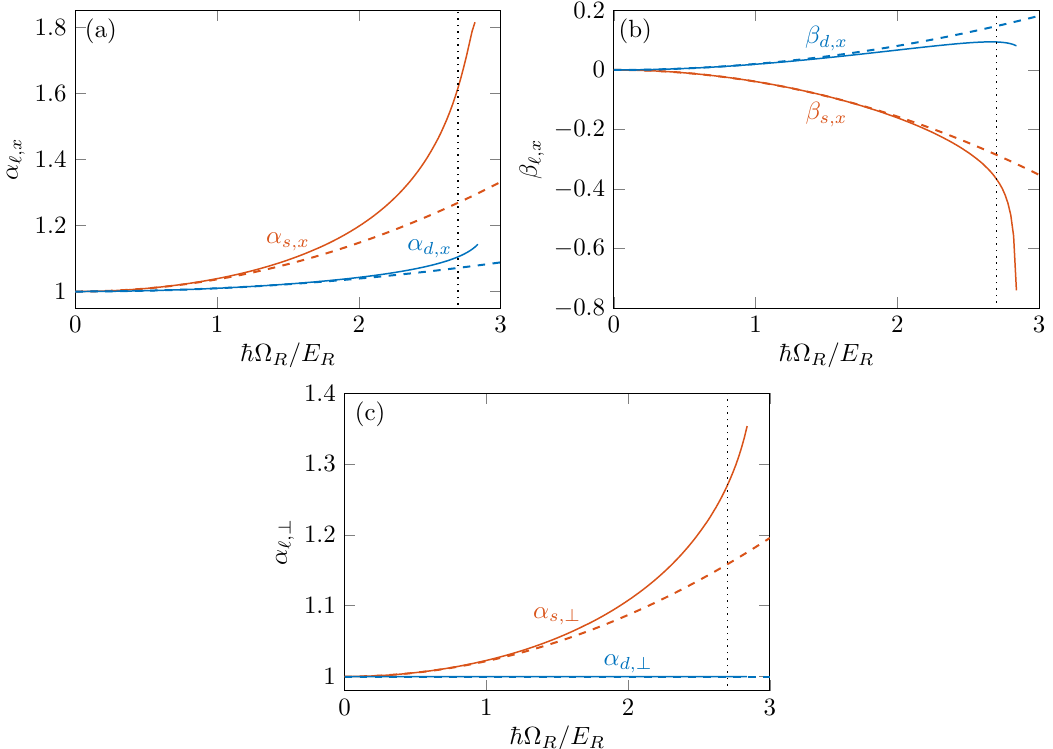
Figure 7: Coefficients of Eqs. (97) as functions of the Raman coupling Ω . We show R the results for excitations propagating [ (a), (b) ] parallel and (c) perpendicular to the x axis (in the latter case only the α ’s are nonvanishing). The solid curves represent the exact numerical values, the dashed ones correspond to the perturbation results obtained for the density (blue) and spin (red) gapless mode. The vertical dotted = 2.70 E lines mark the critical Raman coupling ħ h Ω at which the transition to the R R plane-wave phase takes place. The interaction parameters are the same as Fig.